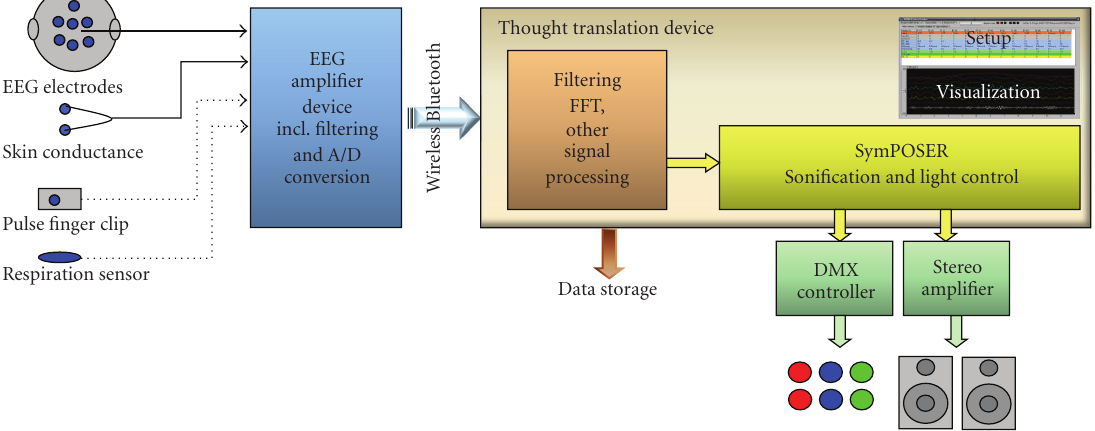
Figure 2: General overview of the multisensory and multimedial feedback system. The TTD software is installed on a PC and is used for data acquisition and preprocessing of the EEG and peripheral signals such as the Electrocardiogram (ECG), skin conductance, or respiration. It is also capable of on-line brain state classification. The SymPOSER module transforms the signals into sound and light. For driving an external feedback environment the sound should be presented over a stereo speaker system and the light control signal is sent to a DMX control unit for driving any studio lighting